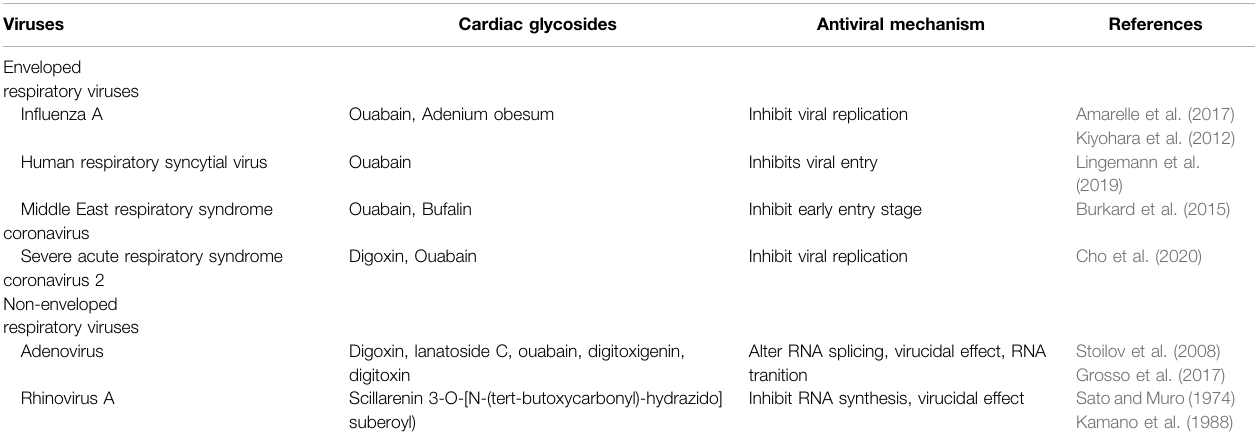
TABLE 2 | Antiviral mechanisms of cardiac